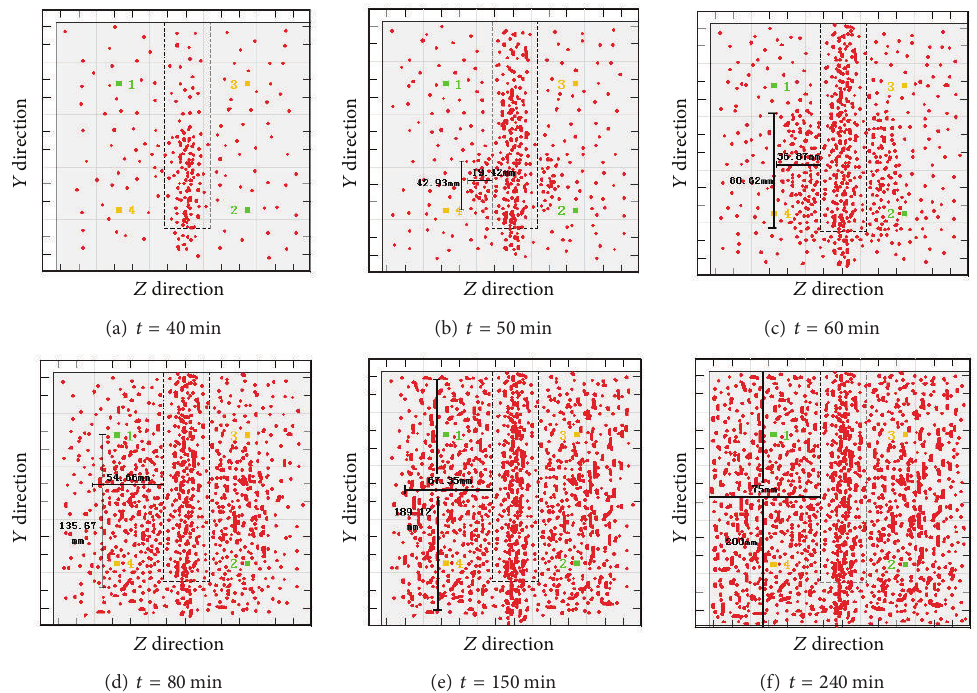
Figure 8: The expansion status of the latter occurring cracks C and D over time.